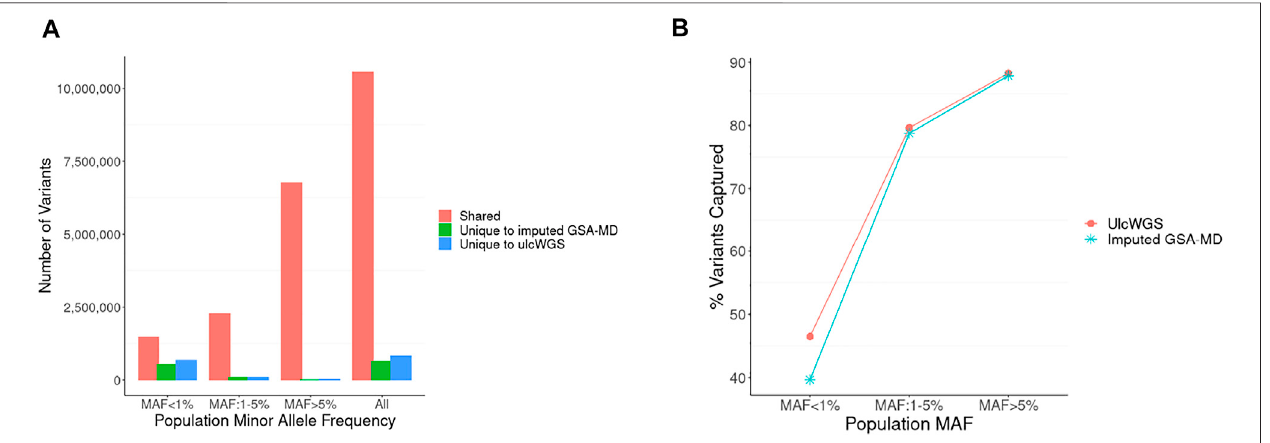
FIGURE 2 | Comparison of variant fraction discovered by ulcWGS vs. imputed GSA-MD. (A) Imputed GSA-MD and ulcWGS data ( N (cid:1) 72) were fi ltered to retain only nonmonomorphic variants. We compared the fi ltered variants between both platforms to evaluate the comprehensiveness of ulcWGS in capturing variants generated by imputed GSA-MD. Numbers of shared and unique variants to each platform were plotted by population MAF derived from non-Finland European population in gnomAD v2.0. (B) The fraction of non-monomorphic variants (Y-axis) from 30 × hcWGS captured by ulcWGS vs. imputed GSA-MD ( N (cid:1) 13 participants genotyped on all three platforms) by different population MAF bins (X-axis). At low (1 – 5%) and common ( > 5%) population MAF, both platforms performed similarly. Forrare variants (MAF < 1%), ulcWGS recapitulatedhigher fraction of30X hcWGS variants, asshown bymore pronounced separation ofulcWGS (redline) and imputed GSA-MD (blue